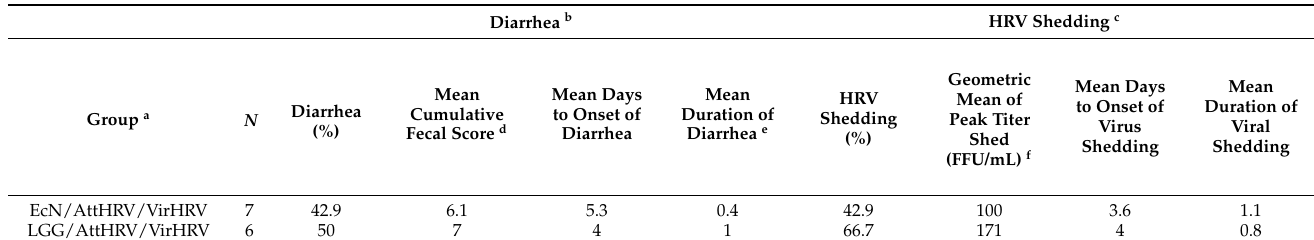
Table 1. The summary of diarrhea and fecal VirHRV shedding post VirHRV challenge